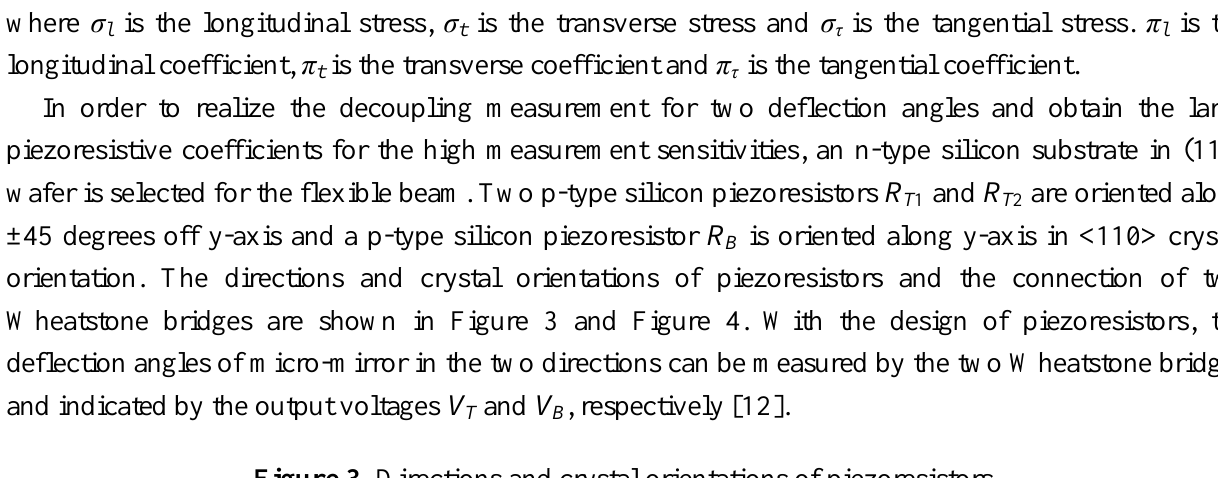
Figure 3. Directions and crystal orientations of piezoresistors.